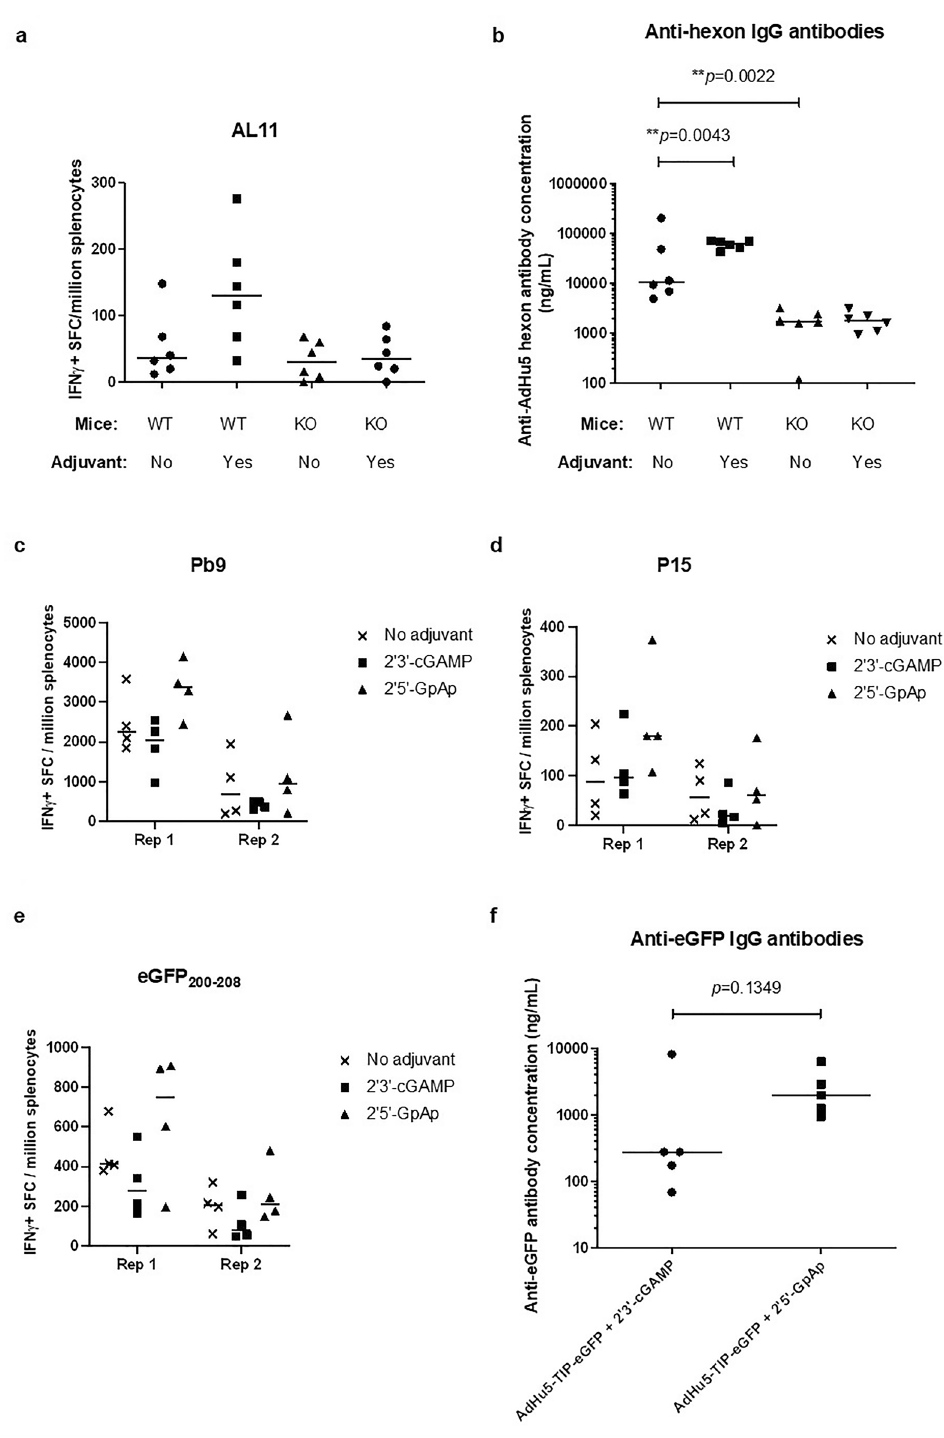
Figure 2. The adjuvant effects of 2 ′ 3 ′ -cGAMP on AdHu5 is dependent on STING. STING-knockout and C57BL/6 mice ( n = 6 per experiment) (panels a & b ) and wild type BALB/c mice (n = 4 per experiment) (panels c - f ) were injected intramuscularly with ~ 10 μg (14.8 nmol) per mouse of 2 ′ 3’-cGAMP or 2 ′ 5’-GpAp mixed with 10 7 IU of AdHu5 per mouse. T and B cell responses were measured 14 days after vaccination. Splenocytes were re-stimulated with a T cell peptide pool spanning the AdHu5 hexon protein ( a ), Pb9 ( c ), P15 ( d ) and eGFP 200-208 ( e ). Splenocyte responses were analyzed using IFN-γ ELISpot. For B cell responses, serum was analyzed using IgG ELISA coating the plates with AdHu5 hexon protein ( b ) or eGFP ( f ). For each panel, Rep 1 and Rep 2 represent independent repetition experiments. Black horizontal lines for each mouse group represent the group medians. Statistical analysis: Mann–Whitney test between treatments within a single experiment (no adjuvant versus 2 ′ 3 ′ -cGAMP or 2 ′ 5 ′ -GpAp, or knockout mice versus wild type mice) (** p <